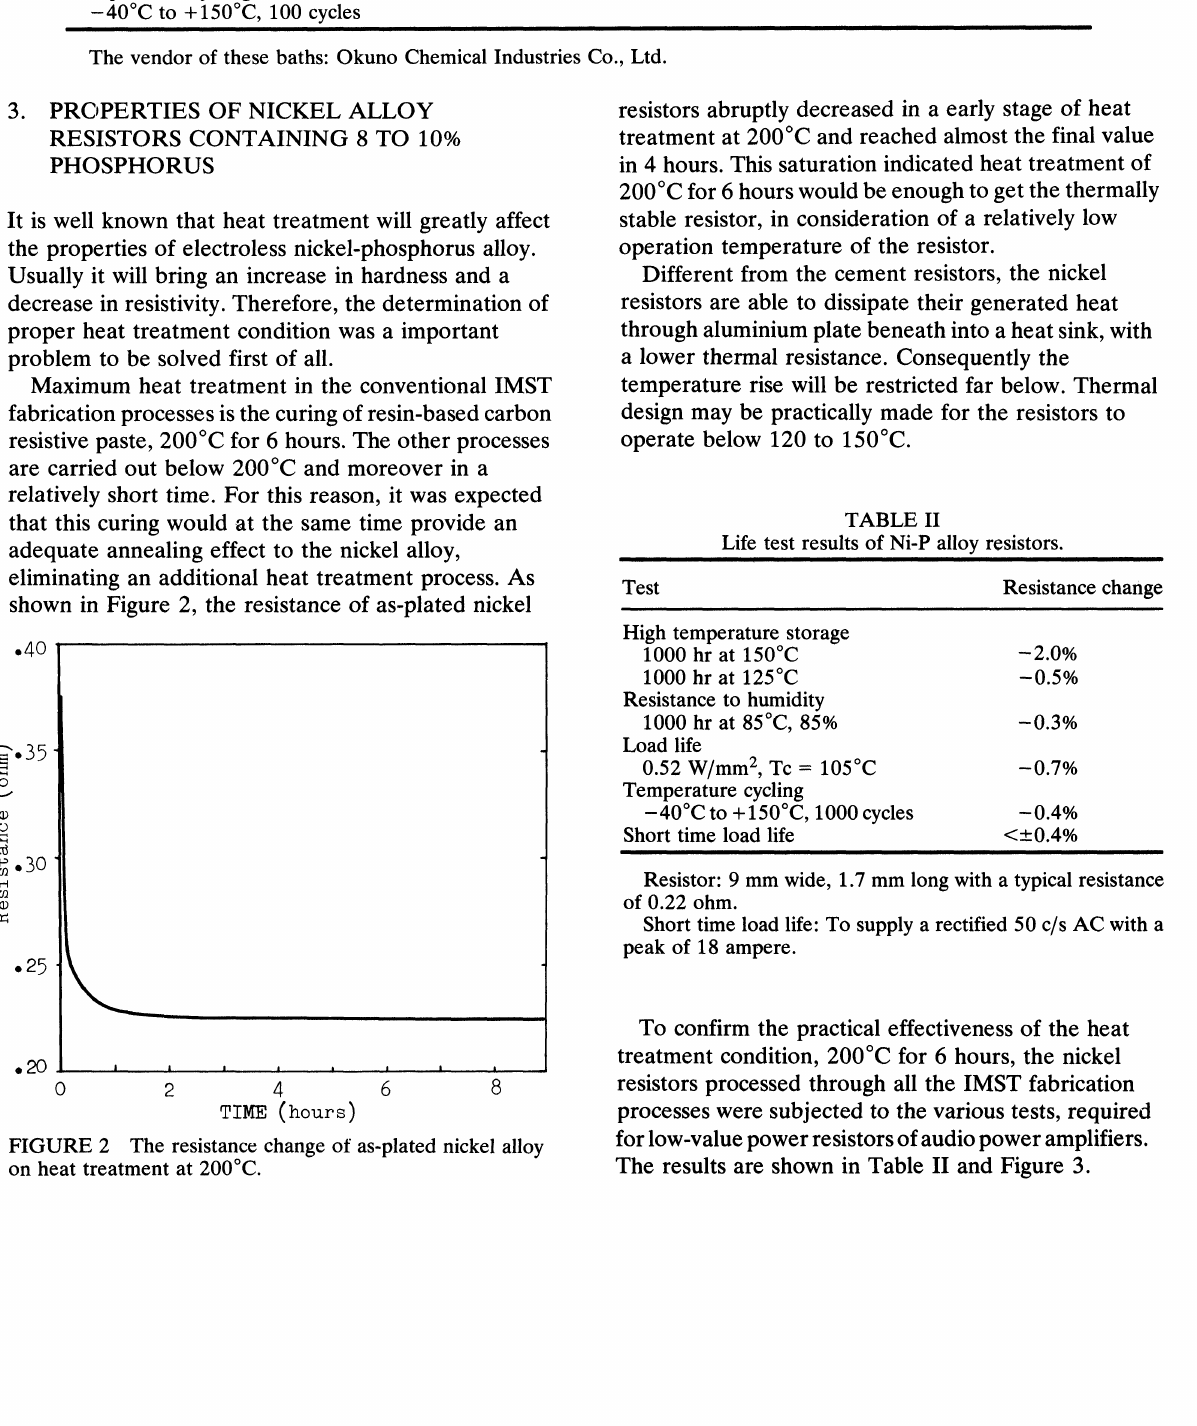
FIGURE 2 The resistance change of as-plated nickel alloy on heat treatment at 200C.